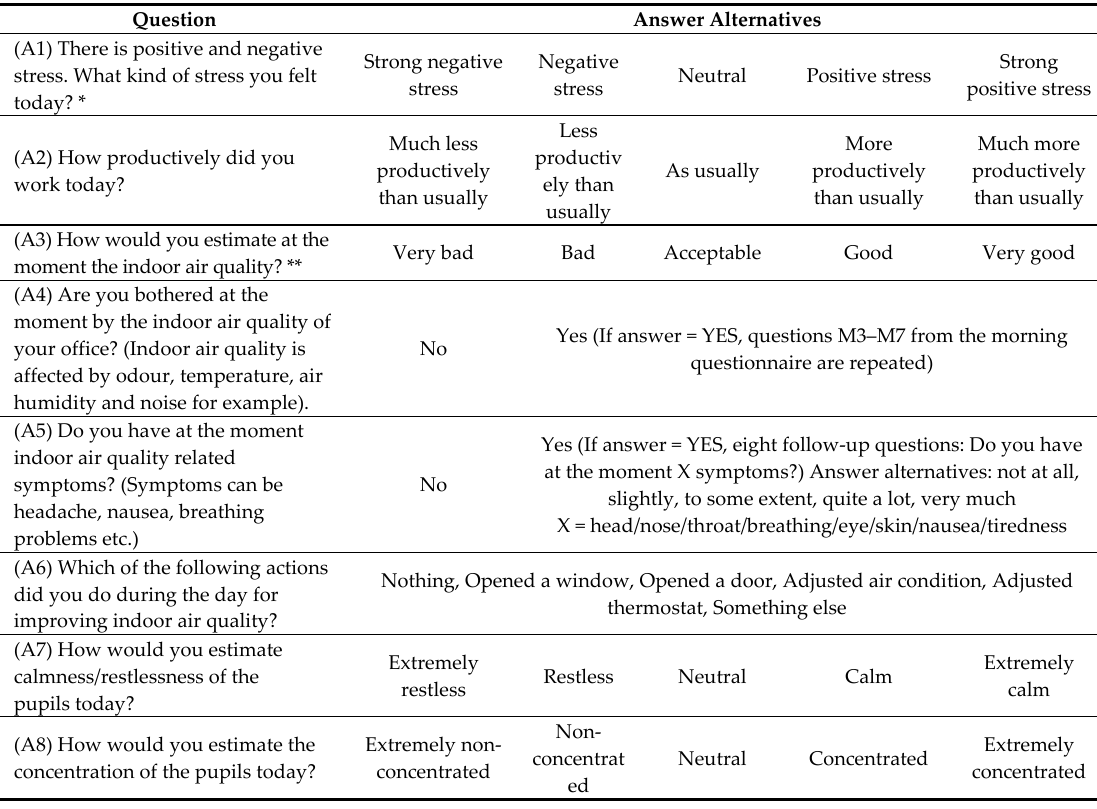
Table 2. Questions in the afternoon